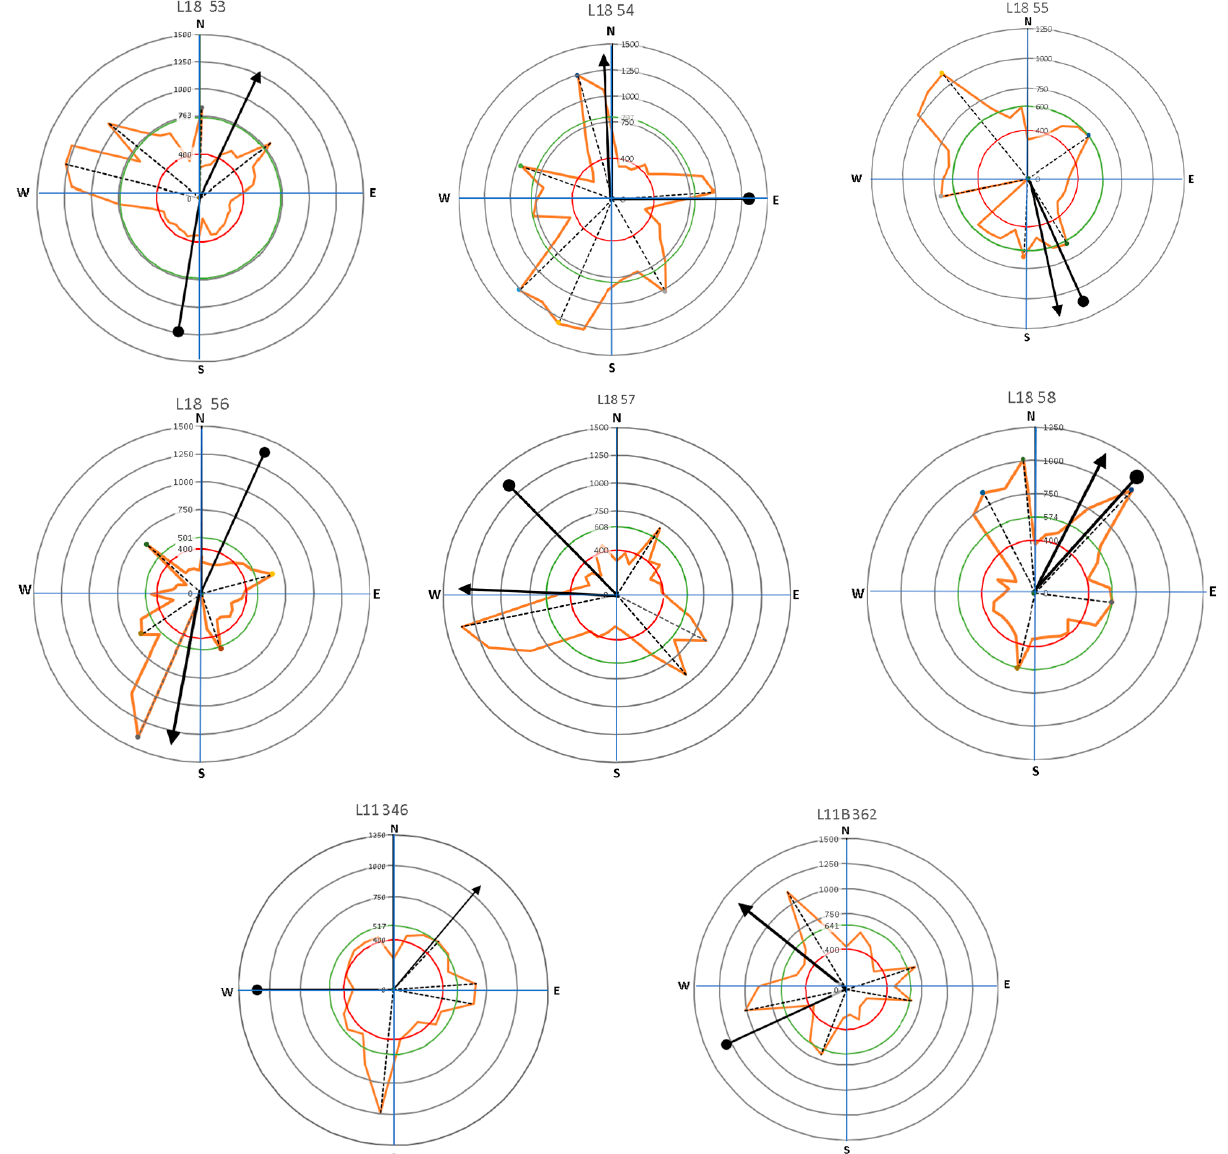
Figure 9. The direction of leaning for Samanea saman trees (circle-head line) and crown development (arrow-head line) in relation to lateral root distribution with the main lateral roots (dash lines).